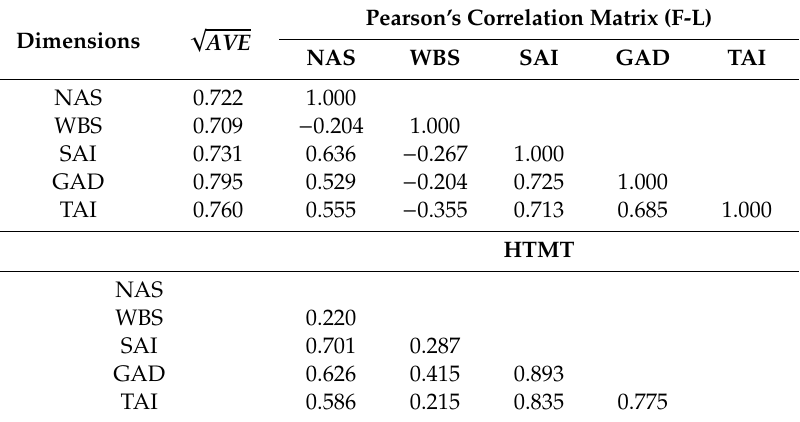
Table 8. Analysis of discriminant validity using Fornell-Larcker and HTMT criteria with the proposed model.